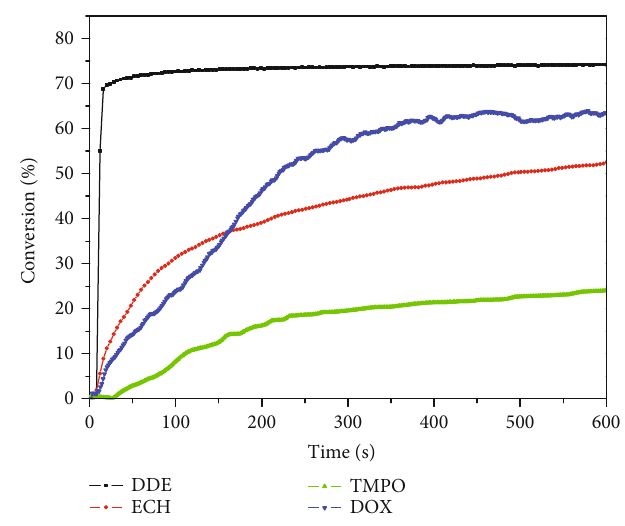
Figure 2: Epoxy conversion curves of di ff erent monomers.